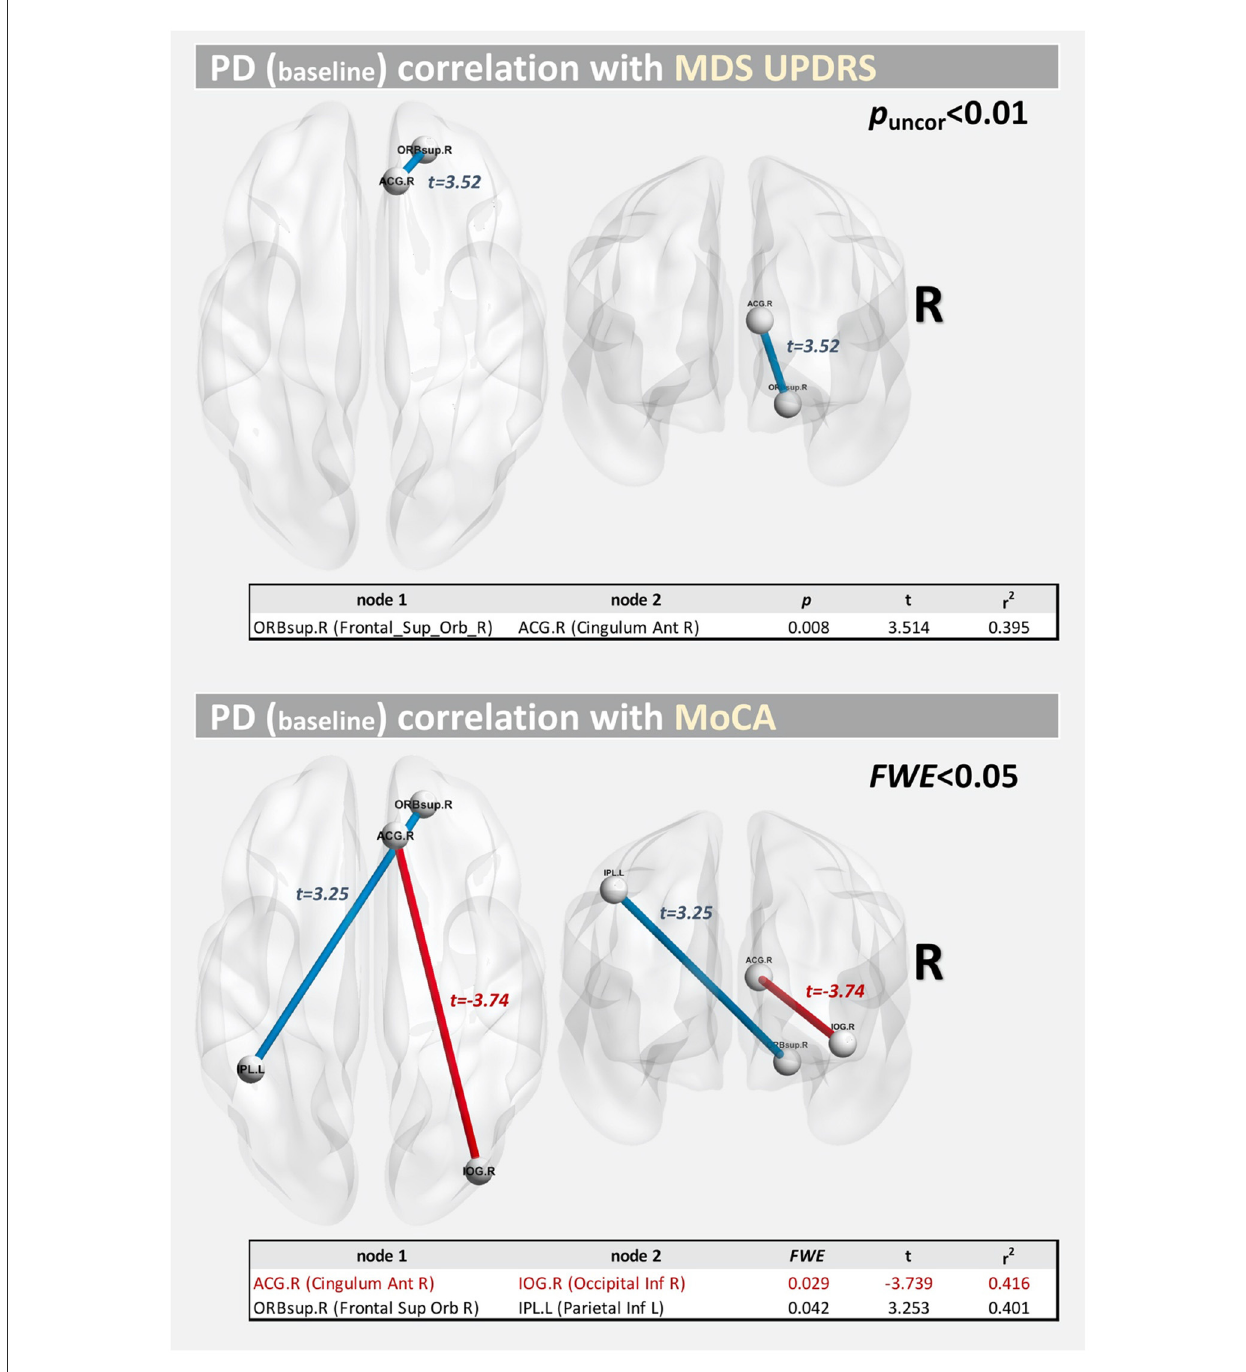
FIGURE7 Correlations between structural connectivity and MDS-UPDRS/MoCA score at